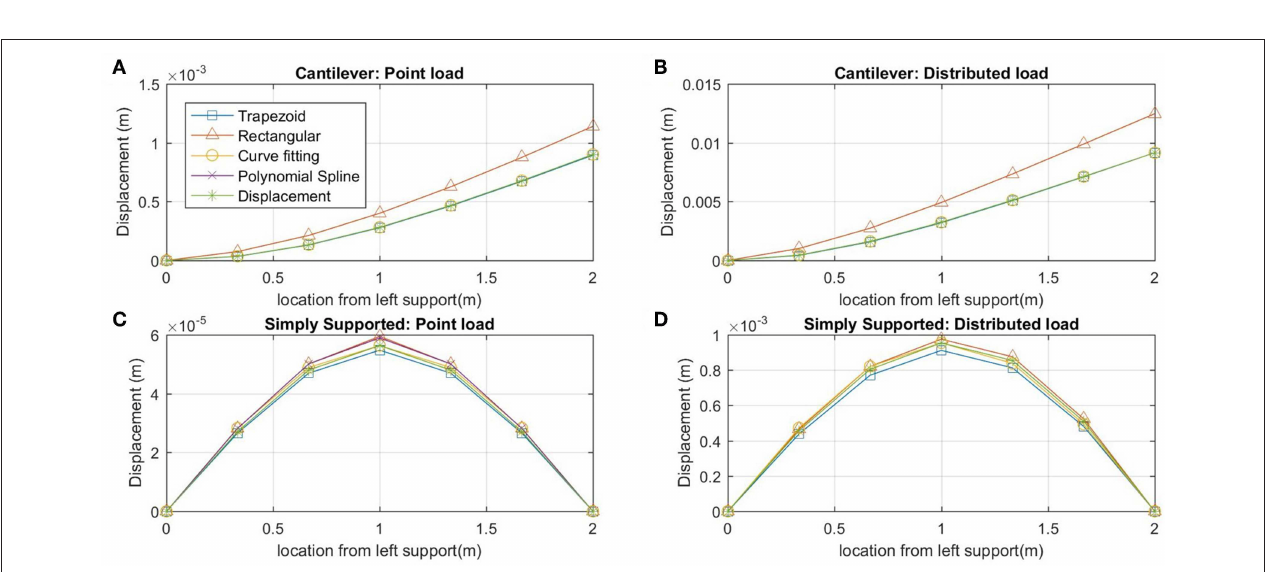
FIGURE 3 | Dimensionless displacement estimations from static beam theory analysis for beam with 7 sensor locations: (A) cantilever with point load, (B) cantilever with uniform distributed load, (C) simply supported with central point load, and (D) simply supported with uniformly increasing distributed load.